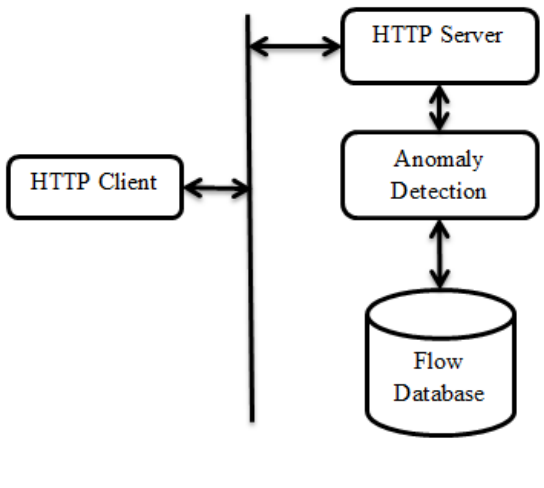
Figure 3. HTTP server Mimicking detection